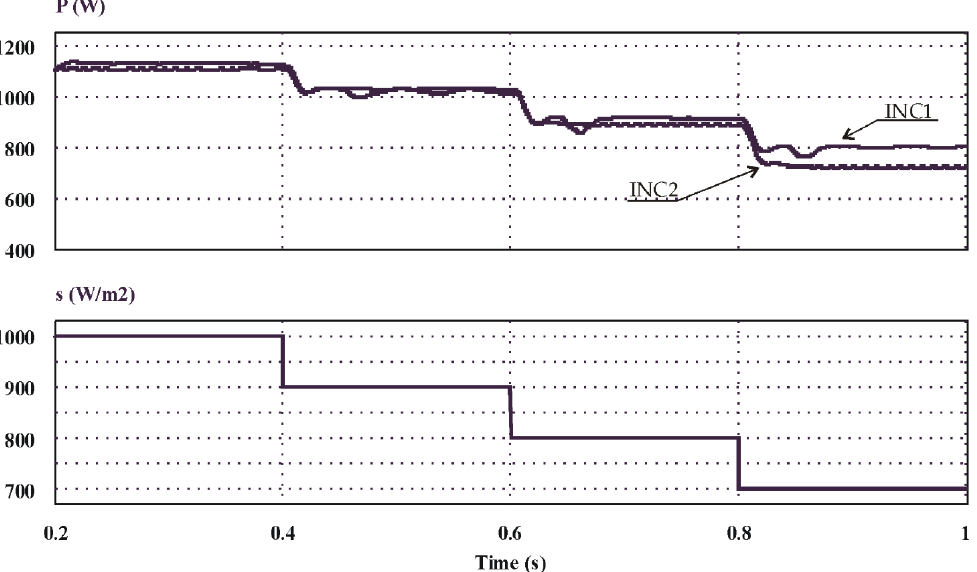
Figure 9. Measured power P in W delivered to the grid and solar irradiance s in W/m 2 for the proposed MPPT method (INC1) and for the incremental conductance MPPT method (INC2) with the incremental value tuned for solar irradiance of 900 W/m 2 .